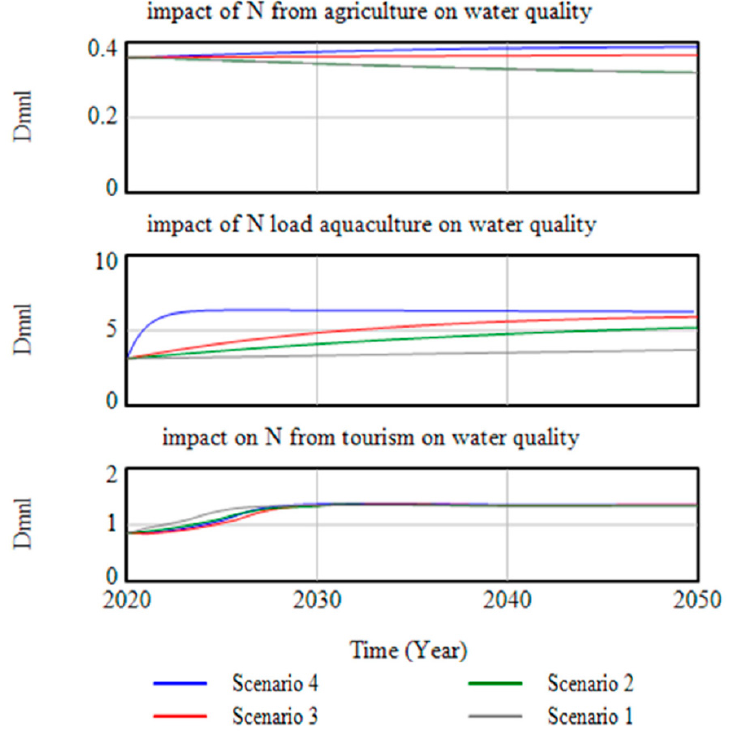
Figure 6. Impact of nitrogen load from agriculture, aquaculture, and tourism in relation to different scenarios of Danube Delta development (results of the model realized in Vensim software produced by Ventana Systems, Harvard, USA).